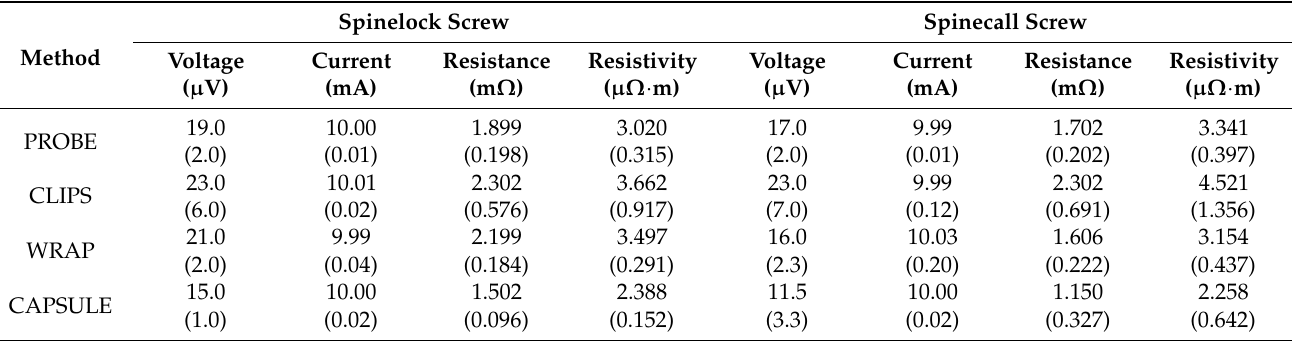
Table 1. Values of voltage and current measured with each coupling method and the corresponding calculated electrical resistance and resistivity, presented as median (interquartile range).